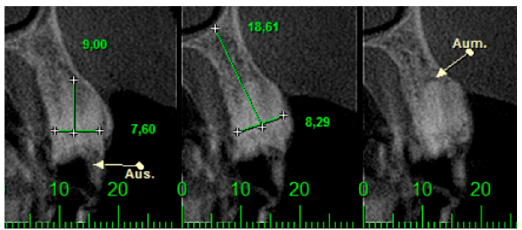
Figure 4. CTCB images of #24 and the radicular fragment.